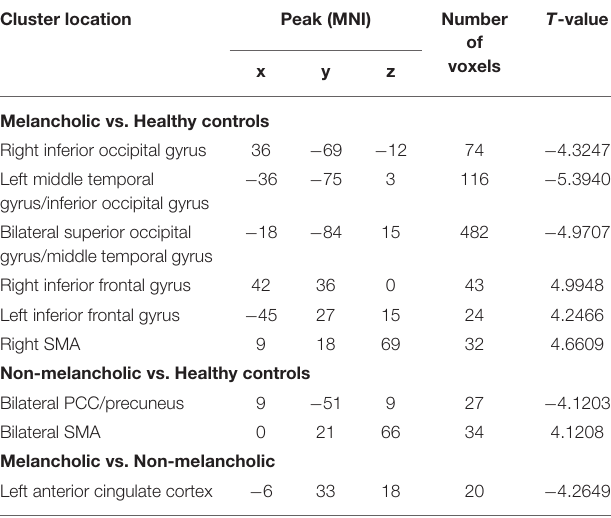
TABLE 2 | Significant fALFF differences across groups. Cluster